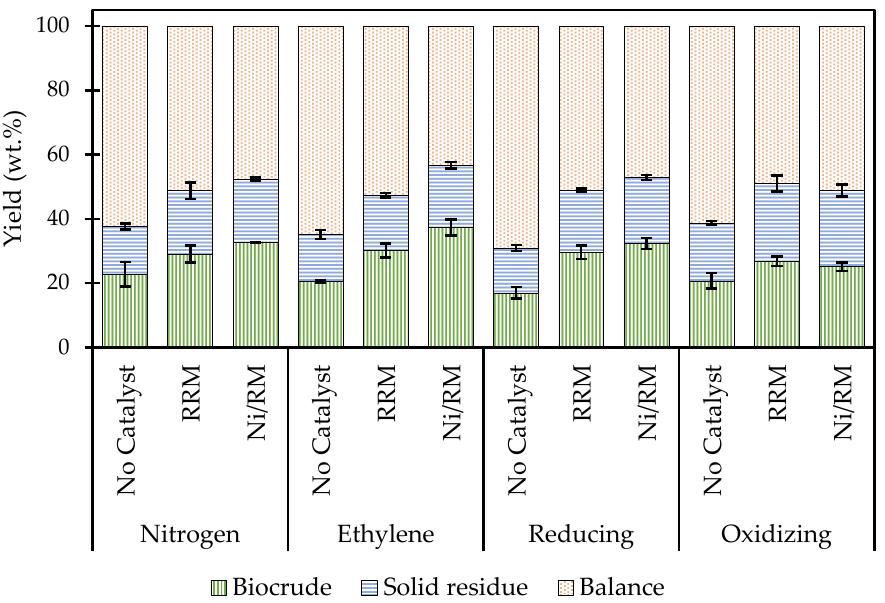
Figure 2. Yield distribution of Tetraselmis sp. (on dry-ash free basis) under different reaction environments and catalysts.